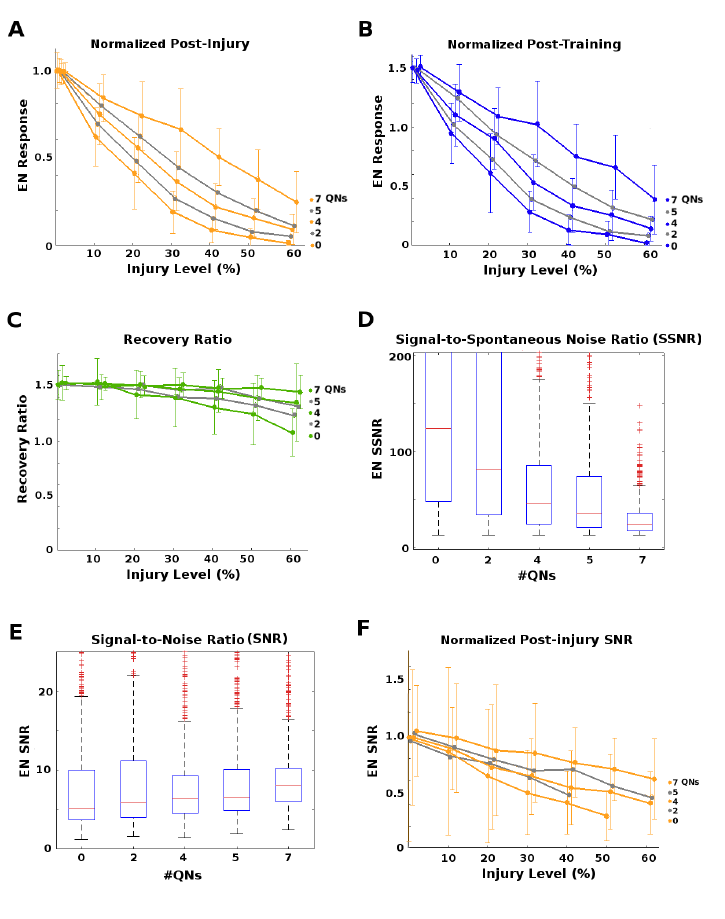
Figure 5. Effects of parallel inhibitory channels. ( A ): Post-injury EN odor responses normalized by naive healthy odor responses, vs. injury level. Each curve corresponds to a number of QNs per 5 PNs, from 0 to 7. Higher QN:PN ratios resulted in much lower impact on EN responses for a given level of injury. ( B ): Post-training EN odor responses normalized by naive healthy odor responses, vs. injury level. Each curve corresponds to a number of QNs per 5 PNs, from 0 to 7. Higher QN:PN ratios resulted in stronger recovery. ( C ): Ratio of post-training to post-injury EN odor responses vs. injury level. Recovery rate dropped off at injury levels ≥ 20% for #QN = 0, but higher numbers of QNs reduced this drop-off, i.e., ensured better recovery. ( D ): Box-whisker plots (showing 25 and 75%iles as a blue box and median as a red line) of the ratio of naive healthy EN odor responses